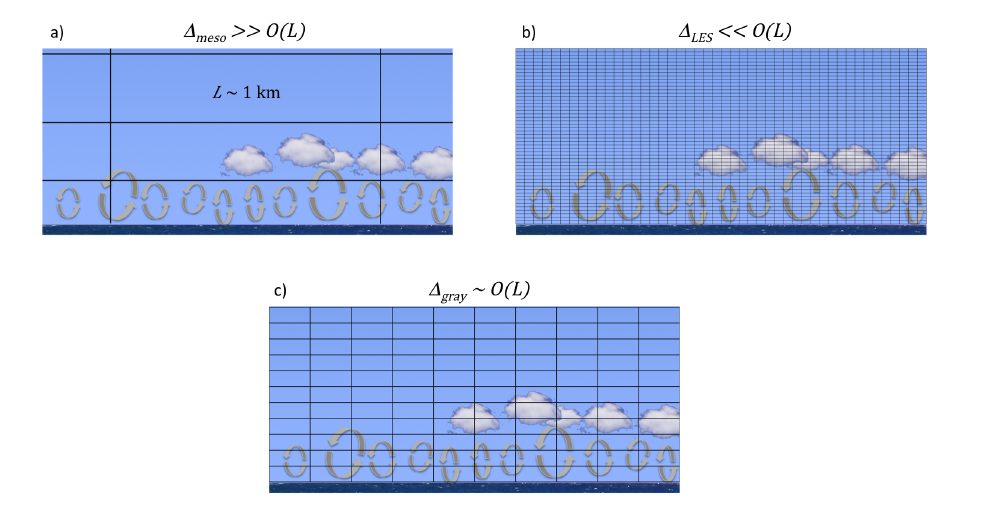
Figure 1. Sketch showing representations of eddies of length scale L ∼ 1 km shown on a vertical grid for: ( a ) a mesoscale model with horizontal grid spacing ∆ >> O ( L ) ; ( b ) a highly-resolved LES with ∆ << O ( L ) ; and ( c ) the gray zone with ∆ ∼ O ( L )